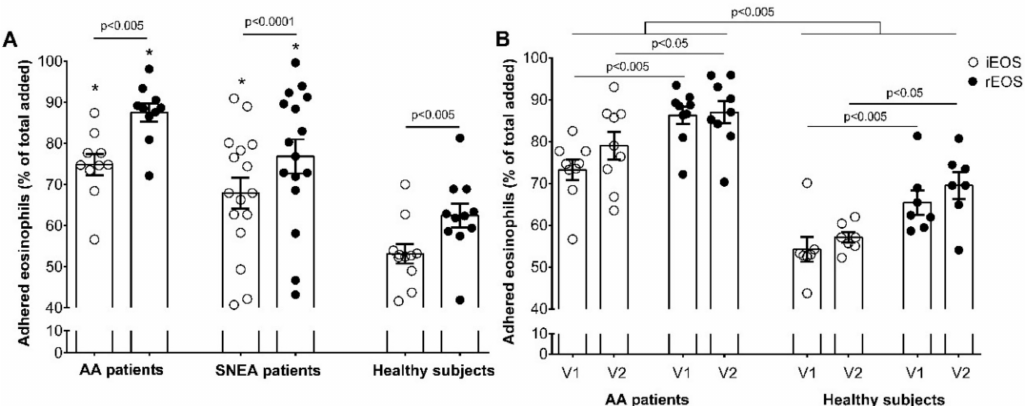
Figure 5. Adhesion intensity of eosinophils subtypes. ( A ) adhesion of blood rEOS and iEOS on ASM cells; ( B ) adhesion of blood rEOS and iEOS on ASM cells after bronchial allergen